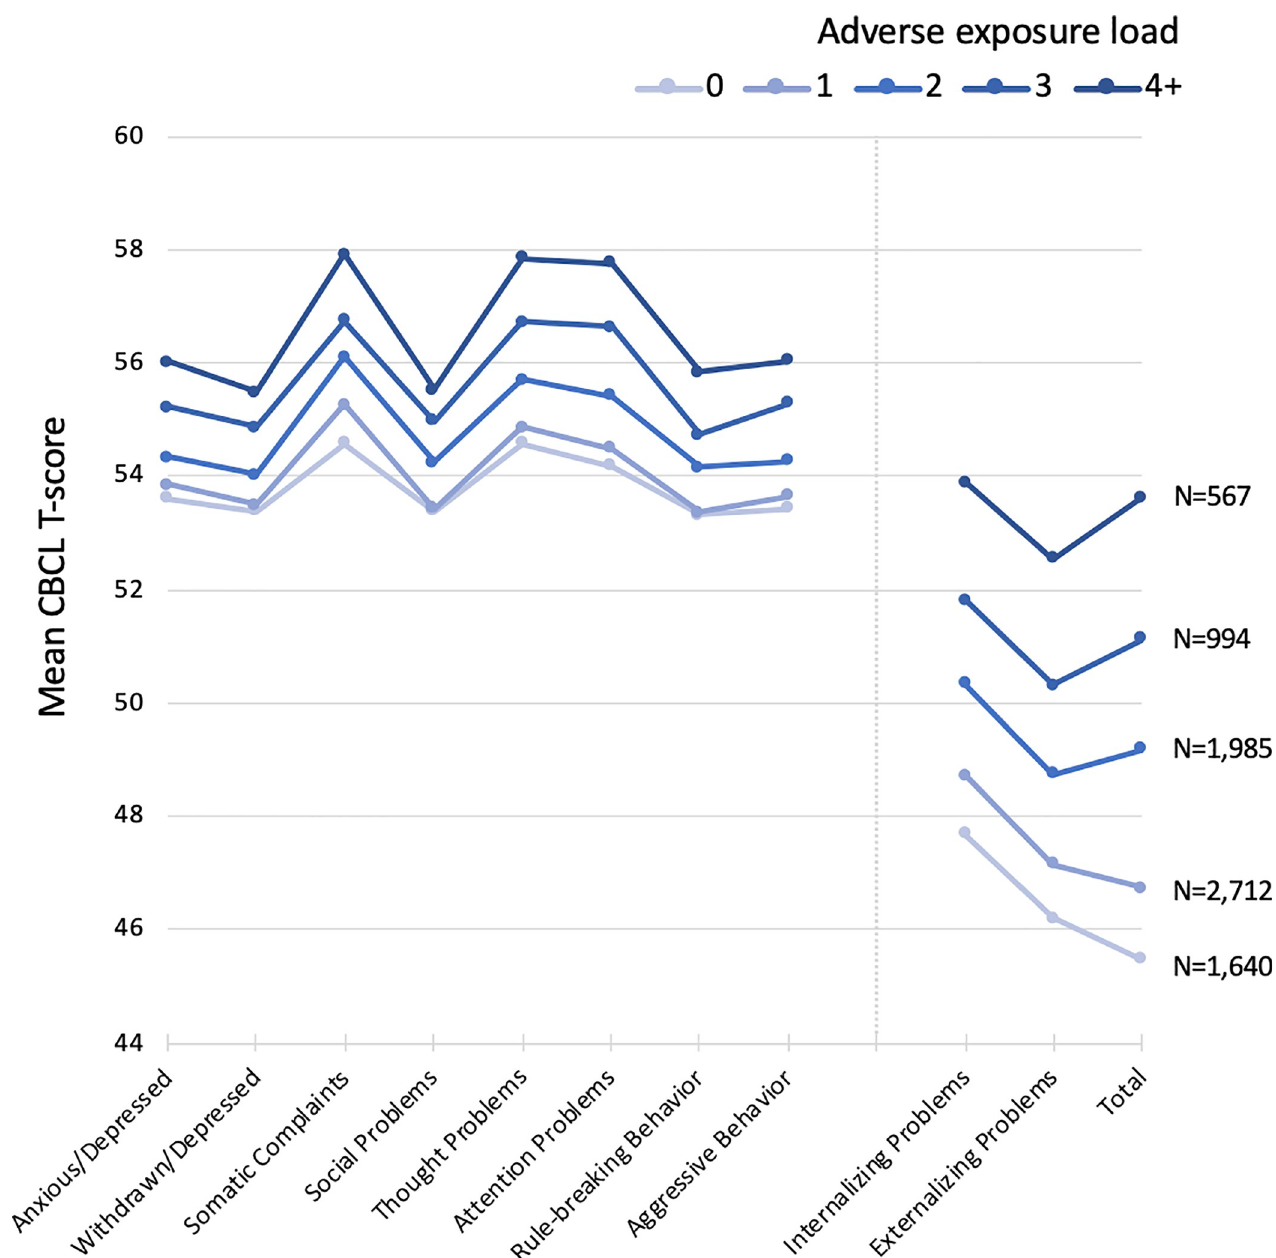
Fig 2. Increased adverse exposure load associated with higher individual syndrome and broad-band CBCL T-scores in the non-sibling group. The association was significant for each T-score scale in fully adjusted models (p < .05, FDR corrected). T-scores � 65 for individual syndrome scores, and � 60 for broad-band scores, are considered clinically